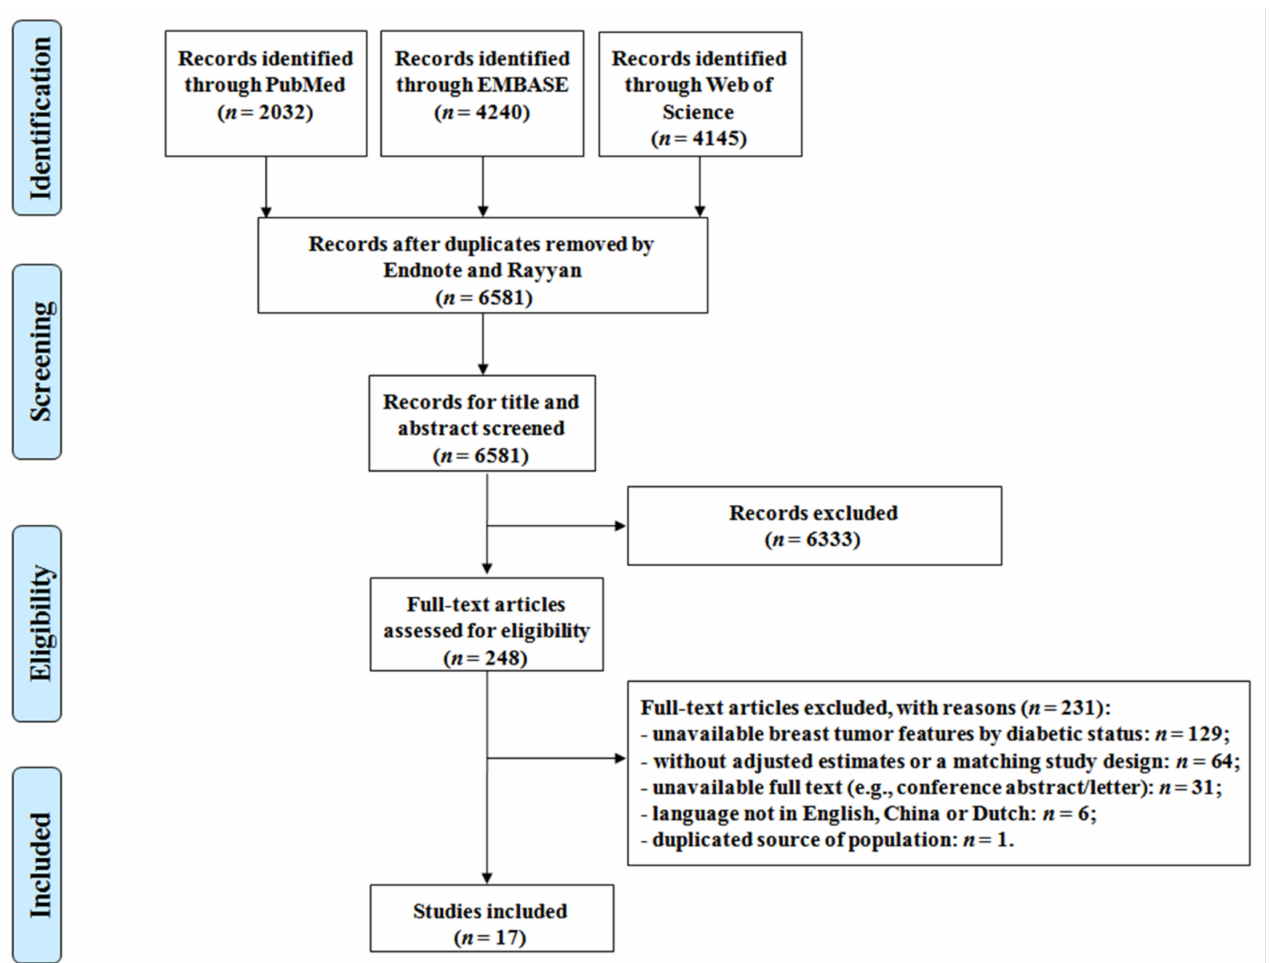
Figure 1. Flow diagram of included